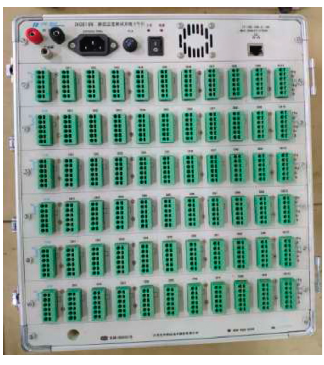
Figure 6: Static strain gauge.